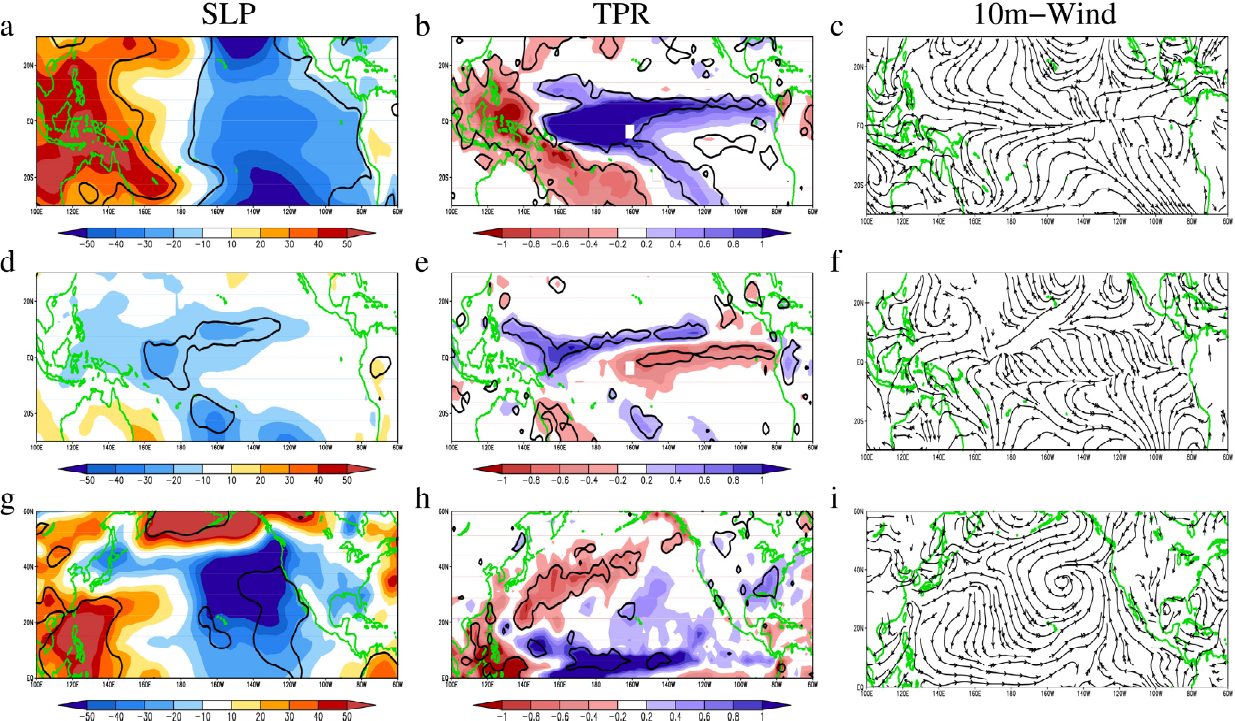
Figure 6. The regression maps of SLP (%/hPa) (left, a , d , g ), TPR (%/mm/day) (middle, b , e , h ) and 10 m wind (stream line) (right, c , f , i ) fields of the time series of CCA pairs associated with EP ENSO (top row), CP ENSO (middle row) and decadal variability (bottom row) over the 1984–2009 period. The associated statistical significance in the highlighted areas is above 95%.